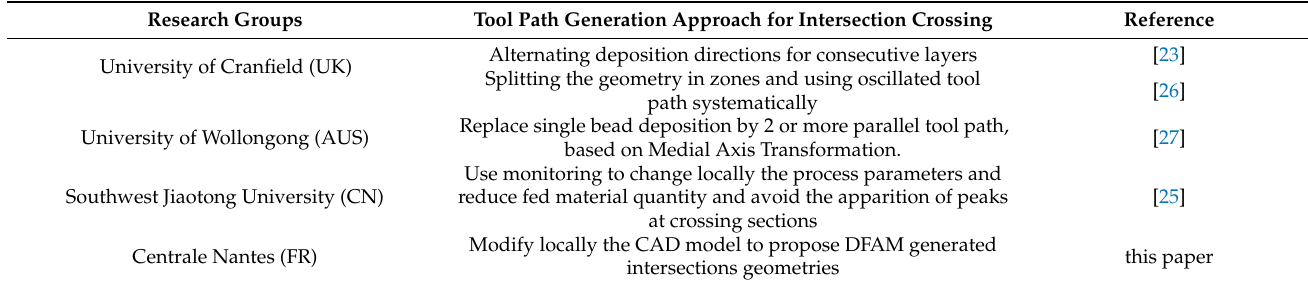
Table 1. Main tool path generation strategies for intersections manufacturing with